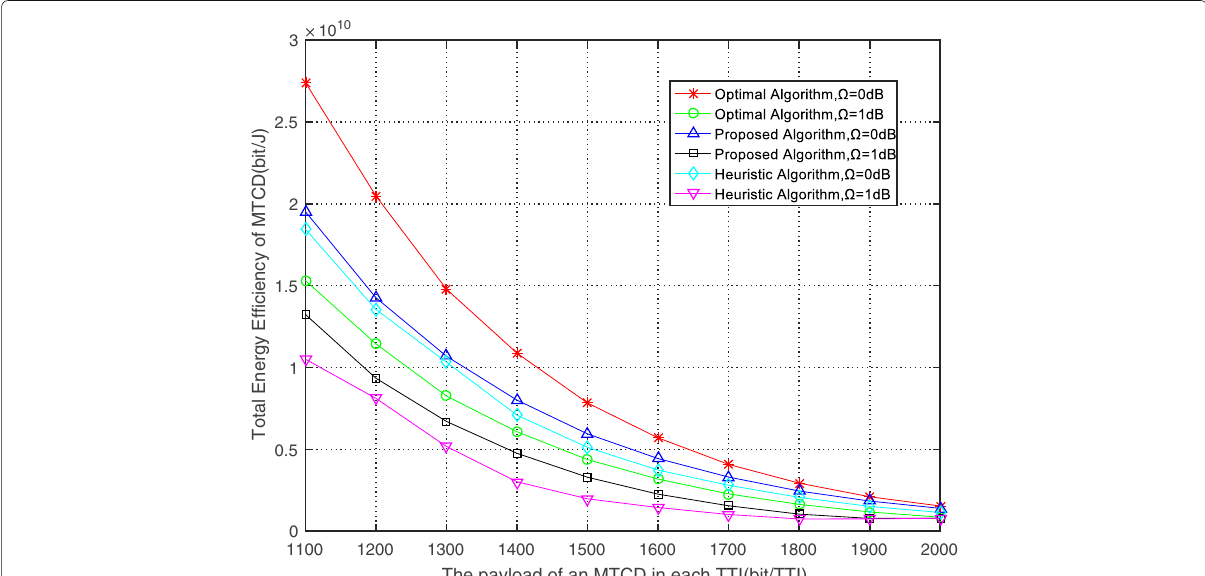
Fig. 3 The total energy efficiency with different payloads. The MTCDs are uniformly distributed in 100-m radius of the MTCG, and the MTCG is uniformly distributed in 1000-m radius of the BS. The number of groups of MTCDs is K = 10. The other configuration parameters are P max k